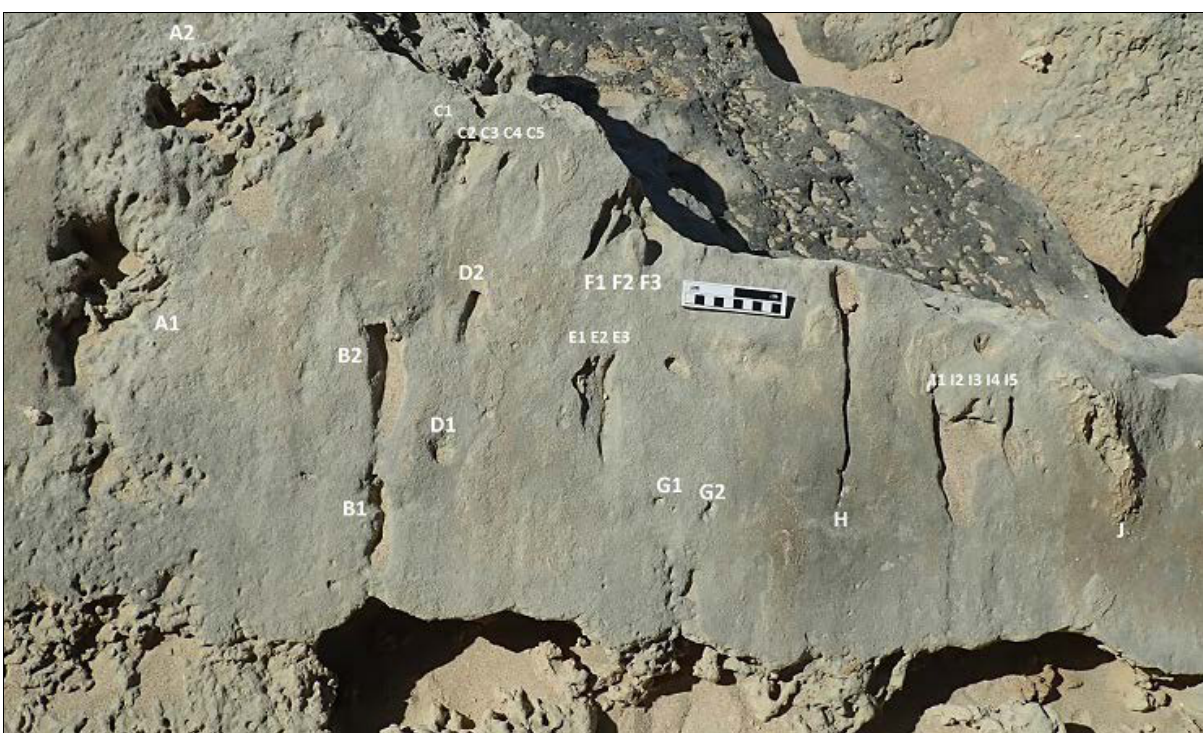
Figure 2: The trace fossil surface, facing south, with labels showing tracks, swim traces and possible coprolite; scale bar = 10 cm. Measurements of labelled features are presented in Table 1.